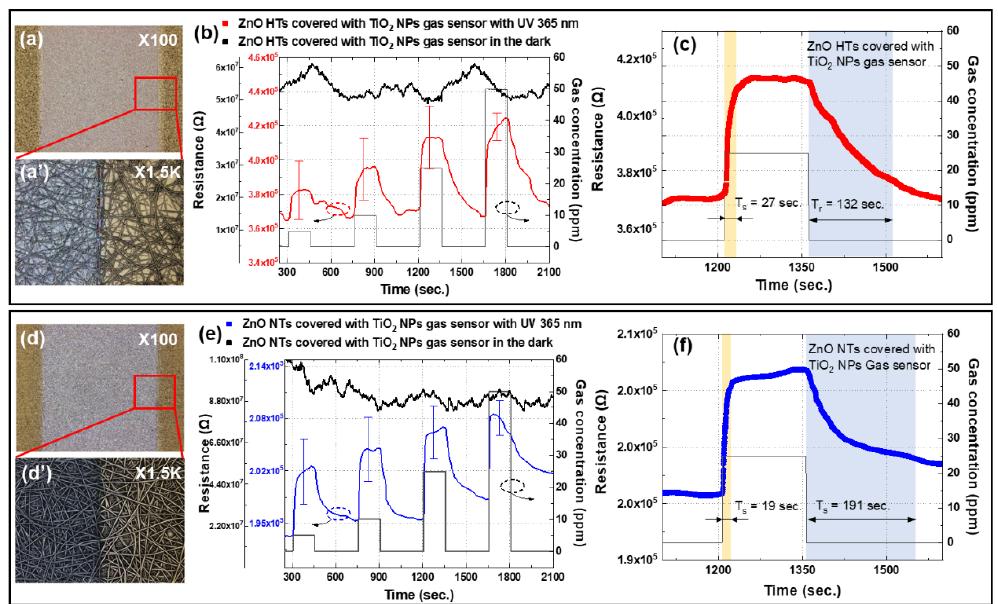
Figure 6. ( a ) Confocal microscopy image of gas sensor consisting of ZnO HTs covered with TiO 2 NPs, ( a’ ) high-magnification image, ( b ) resistance of ZnO HTs covered with TiO 2 NPs gas sensor in response to different NO 2 concentrations with and without UV illumination, ( c ) resistance of ZnO HTs covered with TiO 2 NPs gas sensor to 25 ppm of NO 2 , (d) Confocal microscopy image of gas sensor consisting of ZnO NTs covered with TiO 2 NPs, ( d’ ) high-magnification image, ( e ) resistance of ZnO NTs covered with TiO 2 NPs gas sensor in response to different NO 2 concentrations with and without UV illumination, and ( f ) resistance of ZnO NTs covered with TiO 2 NPs gas sensor to 25 ppm of NO 2